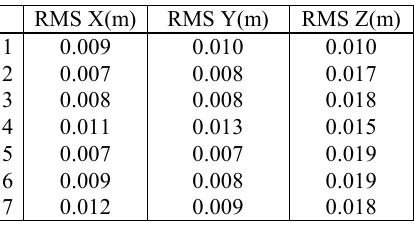
Table 1. RMSs (mean) of the check points (CPs) used in the seven projects